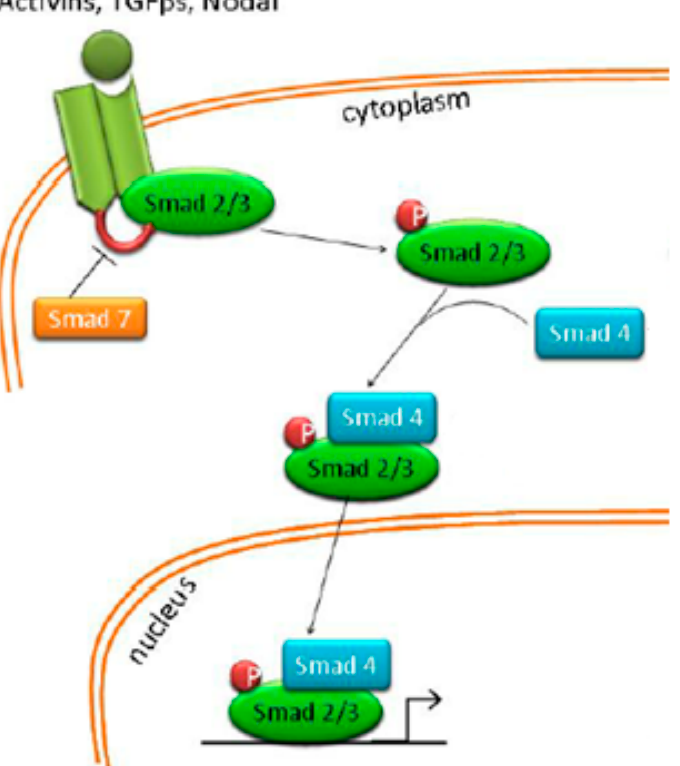
Figure 7. Nodal/activing signalling. Figure replicated from [78] under Creative Commons license, provided at https://creativecommons.org/licenses/by/3.0/ (accessed on 3 February 2023). Changes have been made to the figure legend and the figure has been